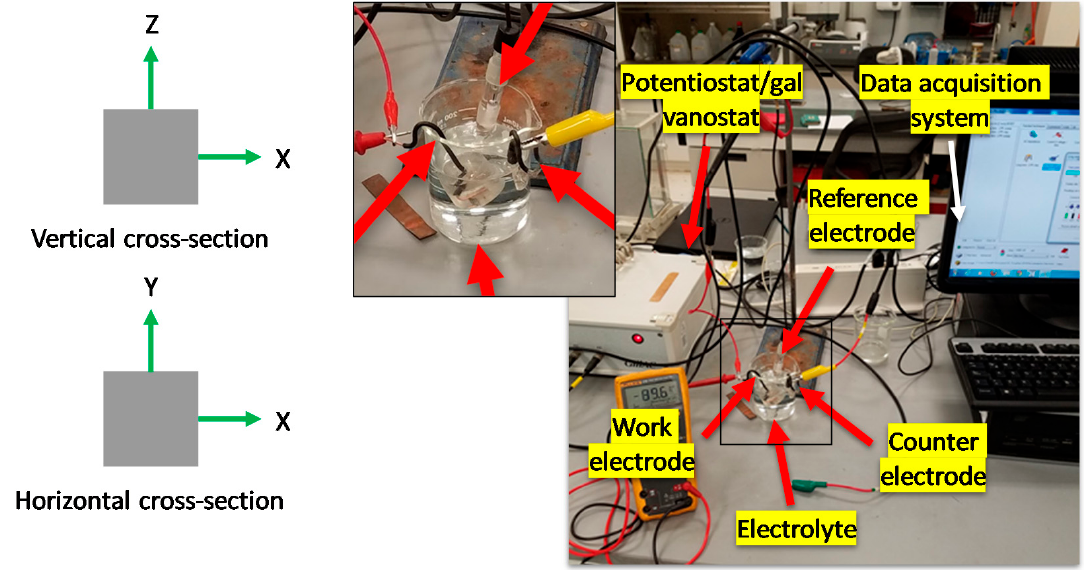
Figure 4. Experimental setup used to perform the corrosion tests; left side, and horizontal and vertical cross-sections (Z axis is parallel to the build direction) of the work electrodes.